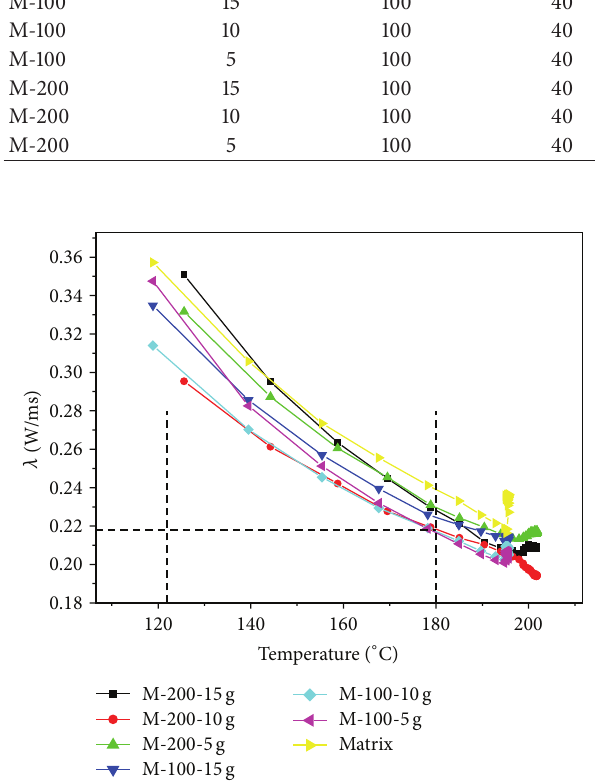
Figure 3: Thermal conductivity of composite materials with two sizes (M-100 and M-200) and three concentrations (15, 10, and 5 g) in the range of 120–180 ∘ C.